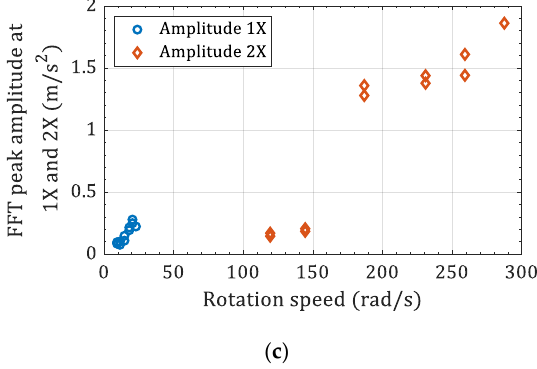
Table 3. The first natural frequency comparison between the present model, manufacturer’s datasheet, and the finite element. Figure 9. The acceleration on the main bearing in ( a ) R direction for 23 Hz rotation, ( b ) the FFT